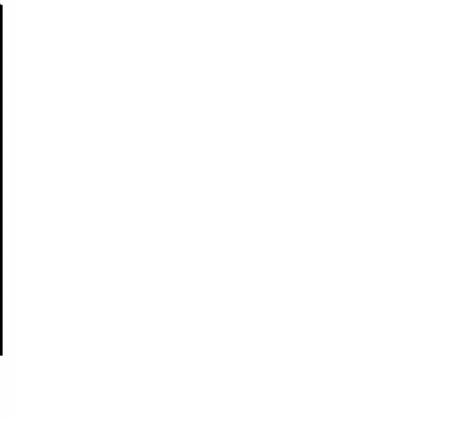
Figure 6. Effects of pH on the adsorption of 3,4,5-TCP by C-O/W microcapsules ( C 0 = 150 mg/L, T = 298 K).